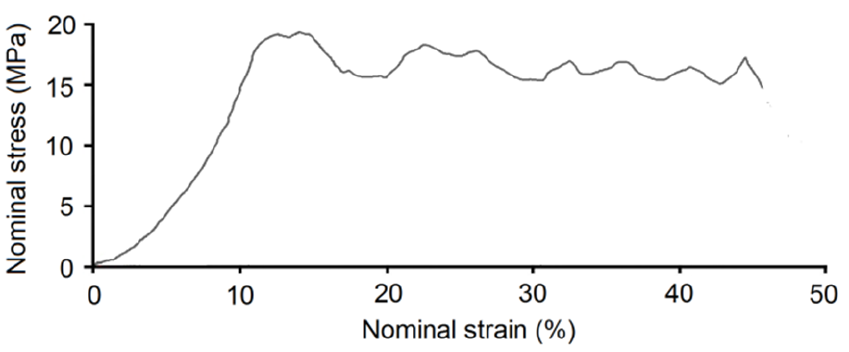
Figure 5. Stress-strain diagram of Ti20Nb5Zr